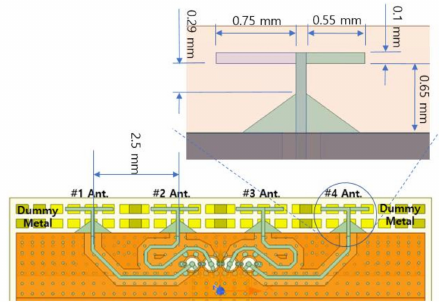
Figure 4. The designed 1 × 4 Yagi array